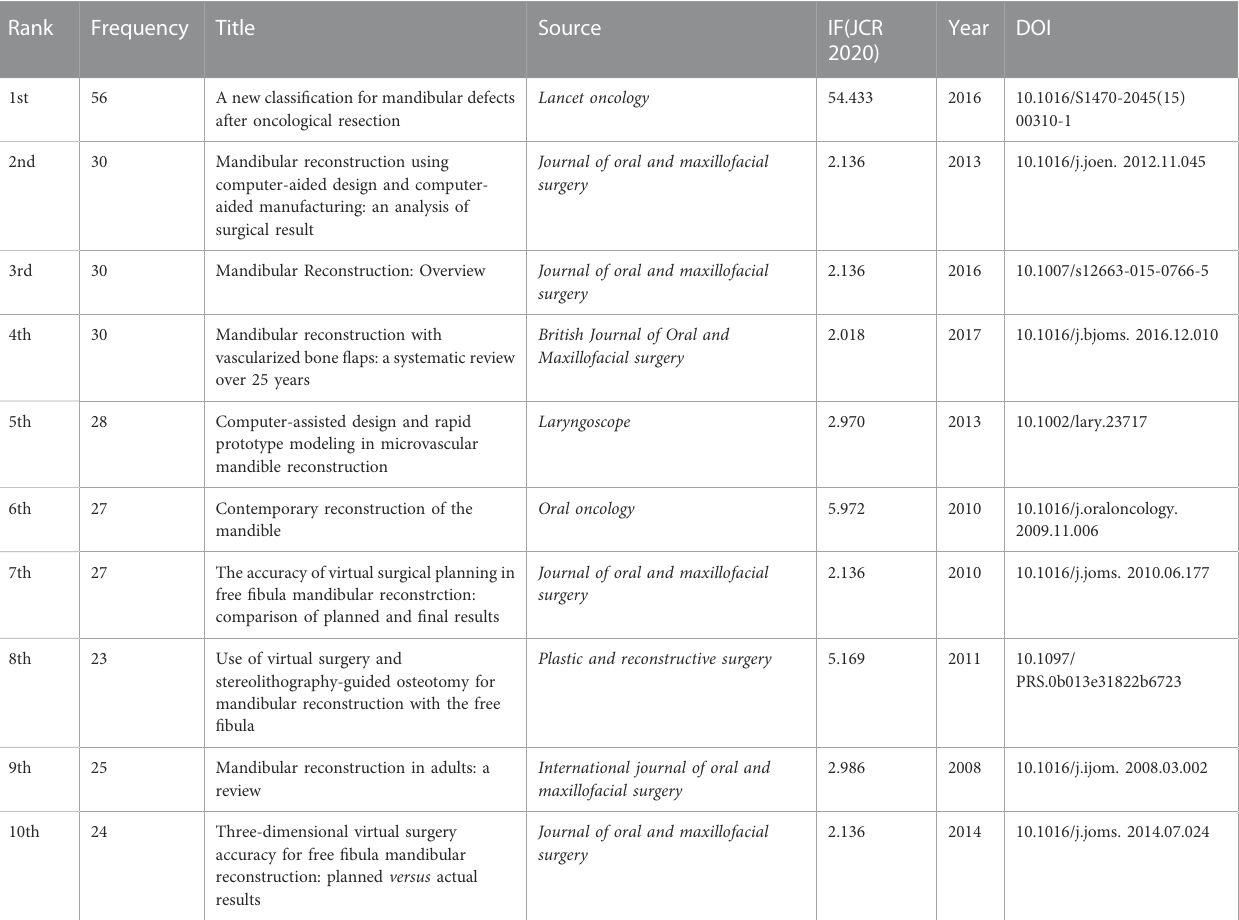
TABLE 4 Top ten co-citation references of mandibular defect